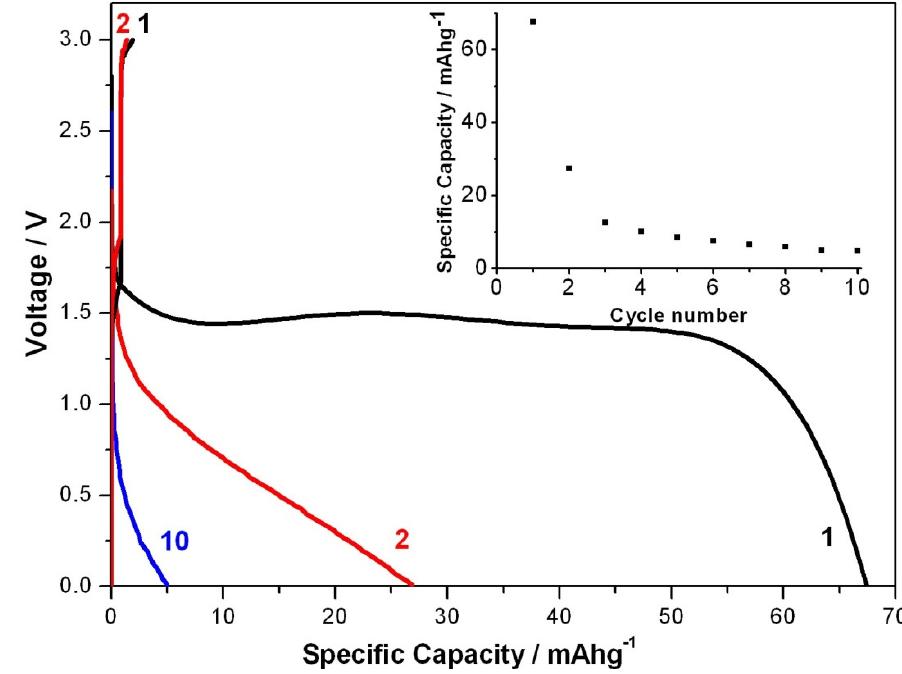
Figure 3. Galvanostatic discharge/charge curves of the textile battery at 1/6 C between 0 and 3 V in coin cell set up. The change of specific capacities with cycle numbers is plotted in the right inset of the voltage